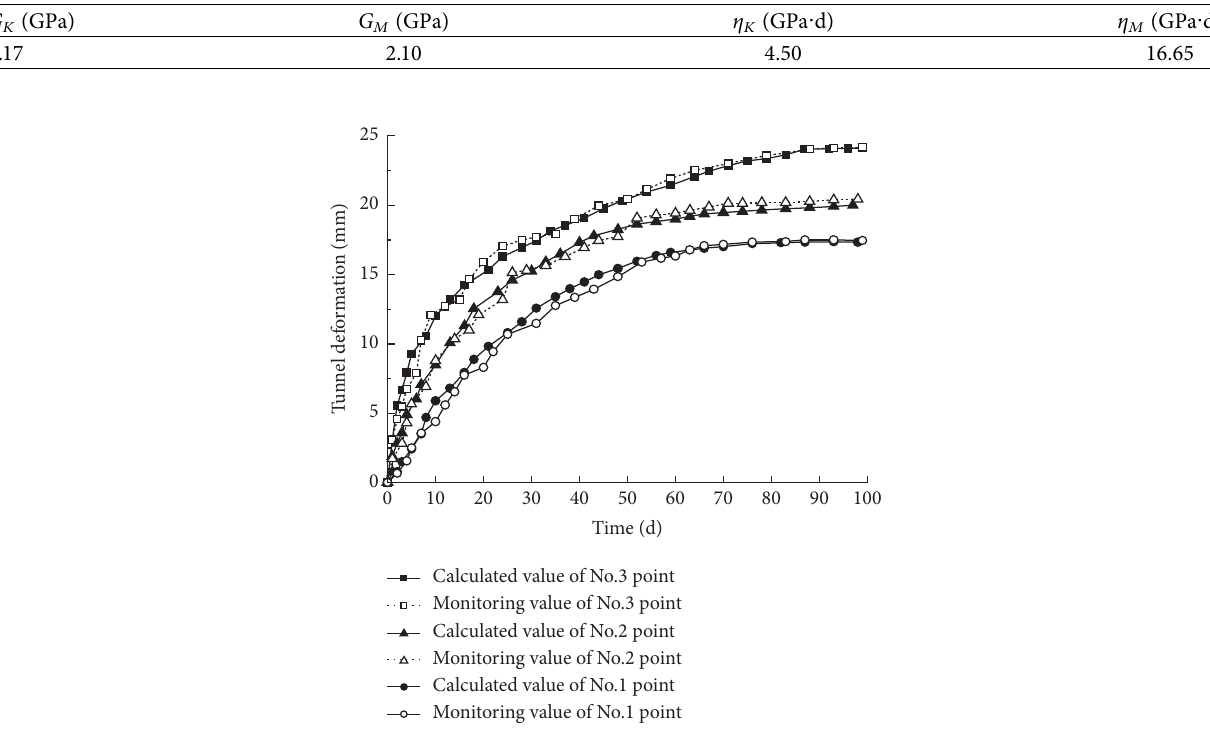
Table 6: Inversion of creep